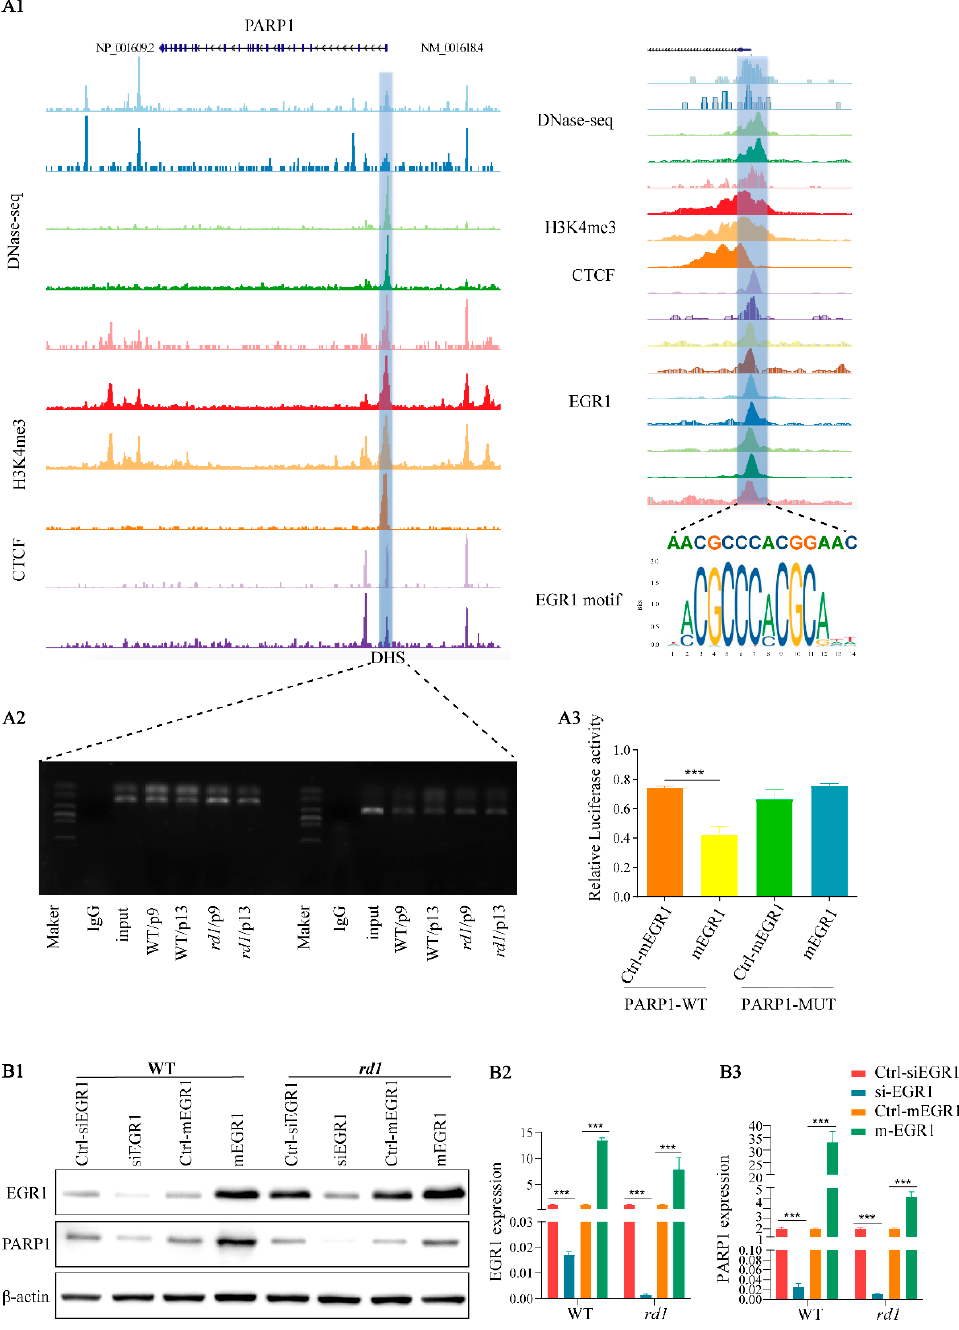
Figure 3. EGR1 binds to the PARP1 promoter region. ( A1 ) Left panel: Signal distribution in the vicinity of the PARP1 locus via DNase-seq, ChIP-seq of H3K4me3, and CCCTC binding factor (CTCF) analysis of the human eye. Colored lines refer to a set of DNase /ATAC/ChIP-seq data, with peaks representing binding at this position. A DNA hypersensitive site (DHS) was found near the tran- scription start site (blue box). Right panel: Magnification of the PARP1 promotor region and DHS site. An EGR1 binding motif was detected in the PARP1 promoter region. ( A2 ) DNA sequencing and ChIP-qPCR analysis revealed that EGR1 binds to the DHS in PARP1 . ( A3 ) The interaction be- tween EGR1 and PARP1 was determined in 293T cell cultures by GLuc /SEAP dual luminescence assay. Co-transfection of EGR1 overexpression and PARP1 in the wild-type (WT) construct resulted in significant inhibition of luciferase activity, indicating an interaction between EGR1 and PARP1. However, such interaction was not observed in the PARP1 mutant (MUT) construct, suggesting specific binding of EGR1 to the WT PARP1 gene. ( B1 ) EGR1 and PARP1 expression were analyzed by western blotting in rd1 and WT retinal explants, cultured from P5 to P13, using either overex- pre ssion (mEGR1) or silencing of EGR1 (siEGR1). ( B2 , B3 ) Quantification of relative EGR1 and PARP1 protein expression. Error bars represent SD. *** = p < 0.001.